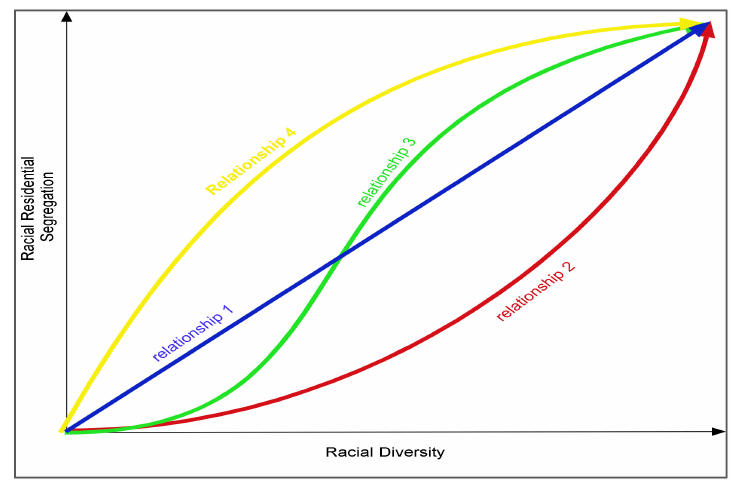
Figure 6. Generalized possible Relationships.